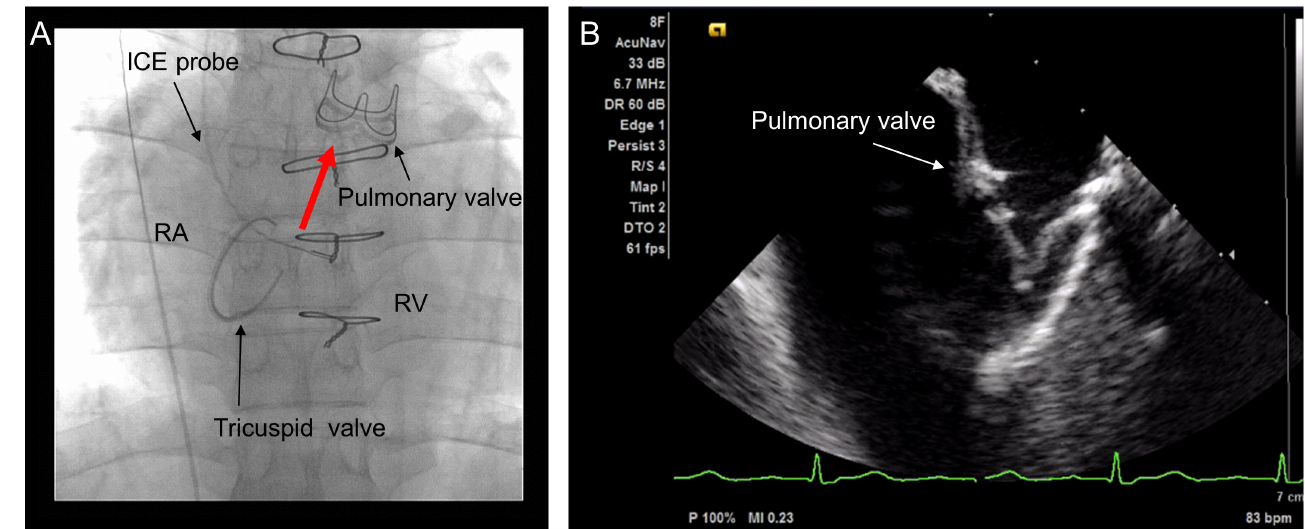
Figure 1. ( A ) Cine angiogram after pulmonary valve replacement (PVR) and ( B ) intracardiac echocardiography (ICE) from the internal jugular vein. A 33-year-old man diagnosed with tetralogy of Fallot underwent intracardiac repair at 6 years of age and PVR with tricuspid ring annuloplasty at 32 years of age. The ICE probe was inserted from the internal jugular vein. The red arrow shows the echo beam. ICE shows excellent visualization of the prosthetic pulmonary valve. RA, right atrium; RV, right ventricle.